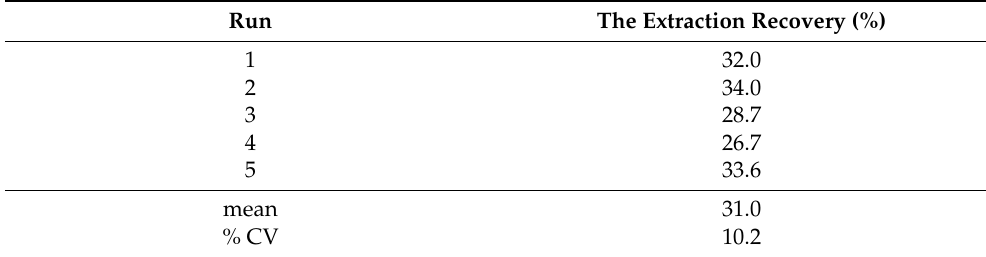
Table 3. Extraction recovery of α -amanitin in rat plasma.